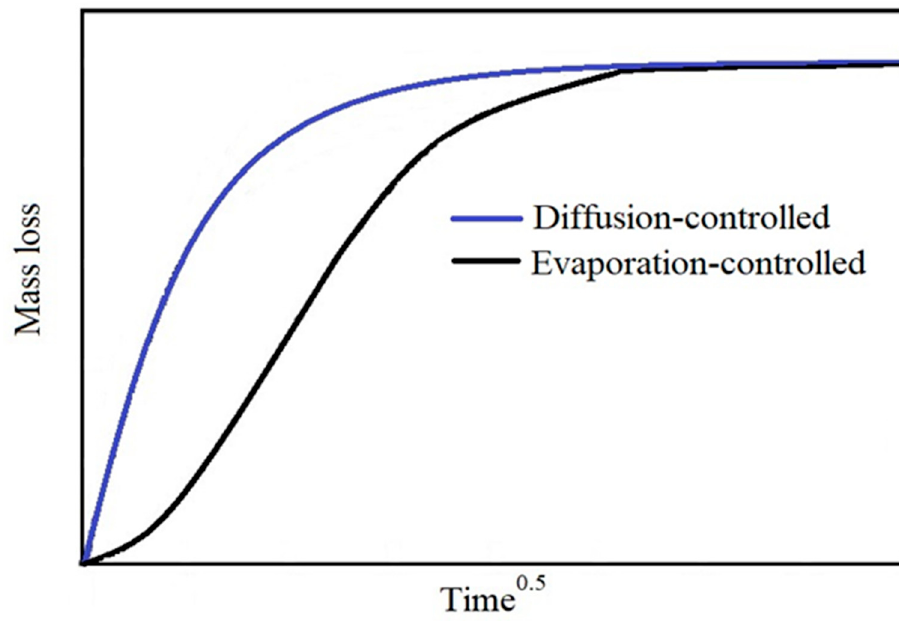
Figure 1. Examples of diffusion-controlled (blue line) and evaporation-controlled (black line) shape concentration profile.